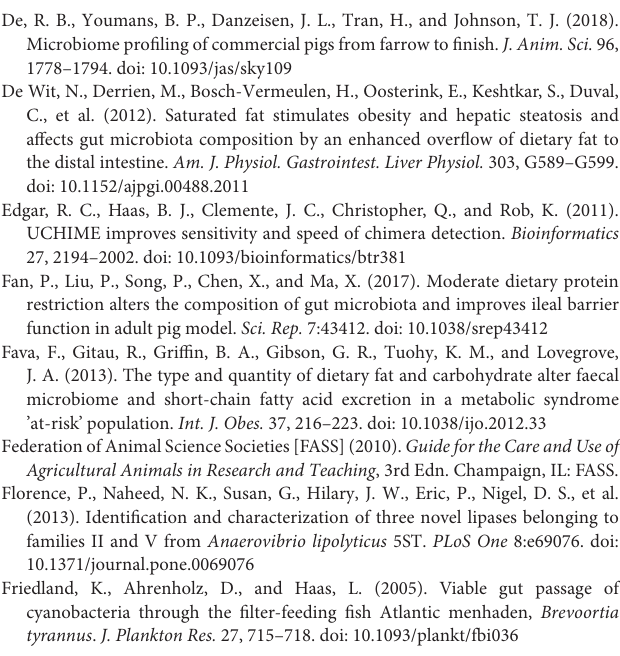
FIGURE S1 | Rarefaction curves of duodenum (A) , jejunum (B) , ileum (C) , cecum (D) and colon (E) samples comparing the number of sequences with the number of OTUs from the microbiota in the digesta of piglets in each treatment group. FIGURE S2 | The relative abundance of the most abundant genera 44 OTUs with a significant difference (the mean abundance more than 2% at least one group) in the SBO, PO, and EPO groups. (analyzed using Kruskal–Wallis sum-rank test) ∗ P < 0.05; ∗∗ P < 0.01. D-, duodenum-; Je-, jejunum-; I-, ileum; Ce-, cecum-; Co-, colon; SBO, soybean oil; PO, palm oil; EPO, encapsulated palm oil. TABLE S1 | Composition and nutrient content of experimental diets (as-fed basis). TABLE S2 | Further evaluation of the statistical significance of the spatial separation among the different groups in PCoA plots using AMOVA analysis ( P